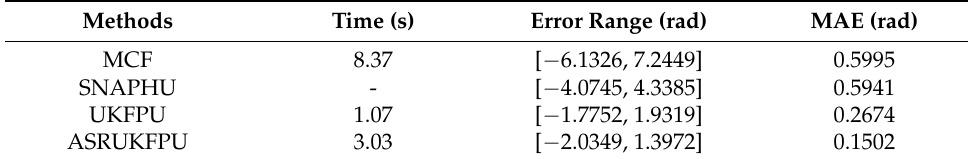
Table 1. The evaluation results of different methods on simulated data.